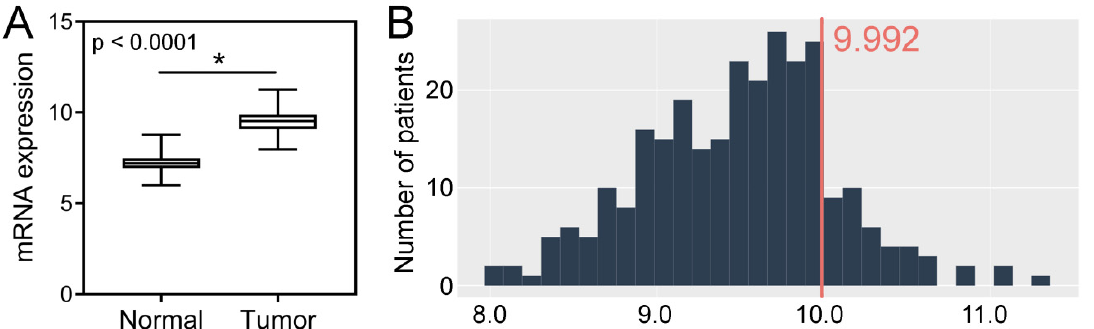
Figure 3. ( A ) The expression level of SPDL1 mRNA in colorectal cancer compared to normal tissues. Analysis was performed based on gene expression data sourced from The Cancer Genome Atlas (TCGA) and Genotype-Tissue Expression (GTEx) databases. The error bars present the range from minimum to maximum values of data. Asterisks (*) indicate statistically significant differences ( p < 0.05). ( B ) The optimal cut-off value for SPDL1 mRNA expression level was established using Evaluate Cutpoints software. Table 3. Association of SPDL1 mRNA expression with clinicopathological parameters of colorectal cancer patients.